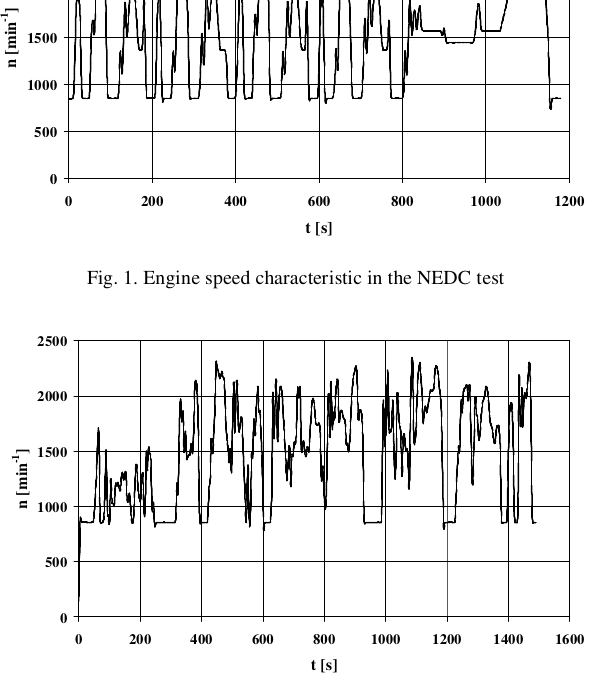
Fig. 6. The relative torque characteristic in the RDE